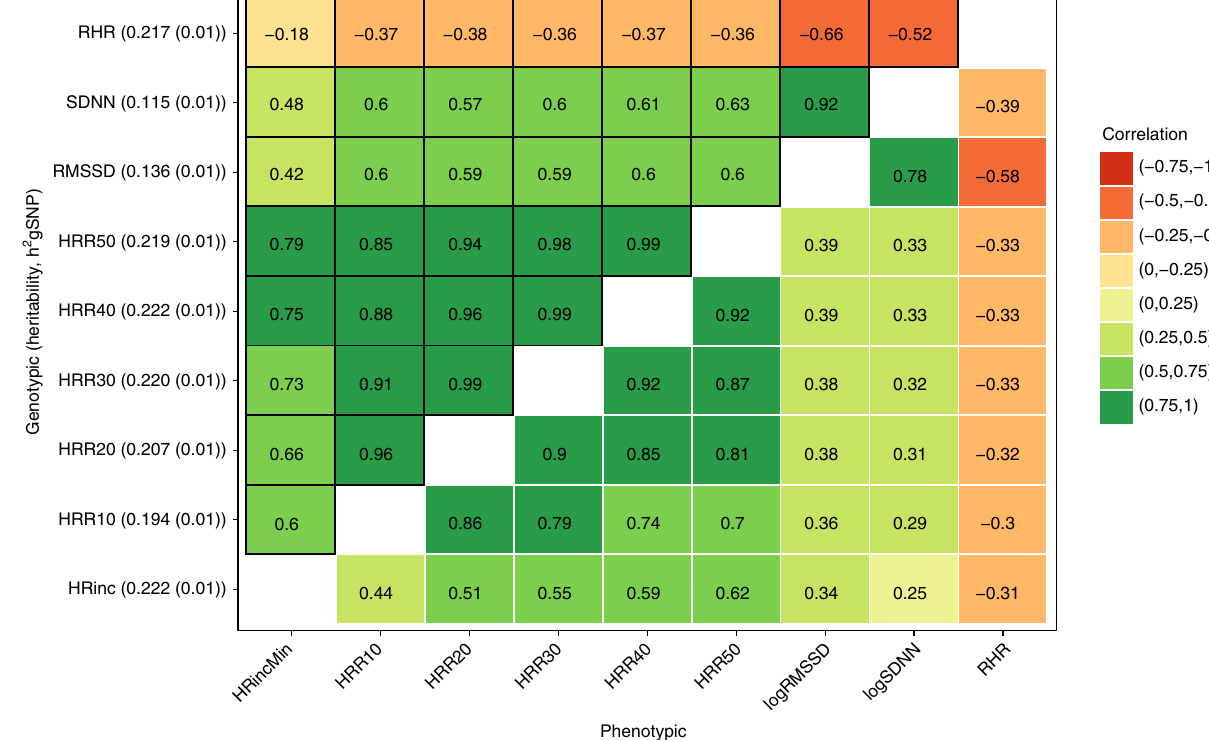
Fig. 1 Shared genetic correlations and heritability estimates of the HR pro fi le during exercise. Genetic correlations (shared heritability), are shown above the diagonal, phenotypically observed correlations are below the diagonal. Heritability estimates (and standard errors) of each trait are between brackets at the y-axis. All of the estimates shown here were highly signi fi cant ( p < 10 − 8 ). Correlations are based on the residual variance after adjustments for age, sex and BMI, exercise-speci fi c variables and genetic-speci fi c variables (only for the genetic Table 1 List of 25 genome-wide signi fi cant SNPs in 23 loci that are associated with HR increase or HR recovery